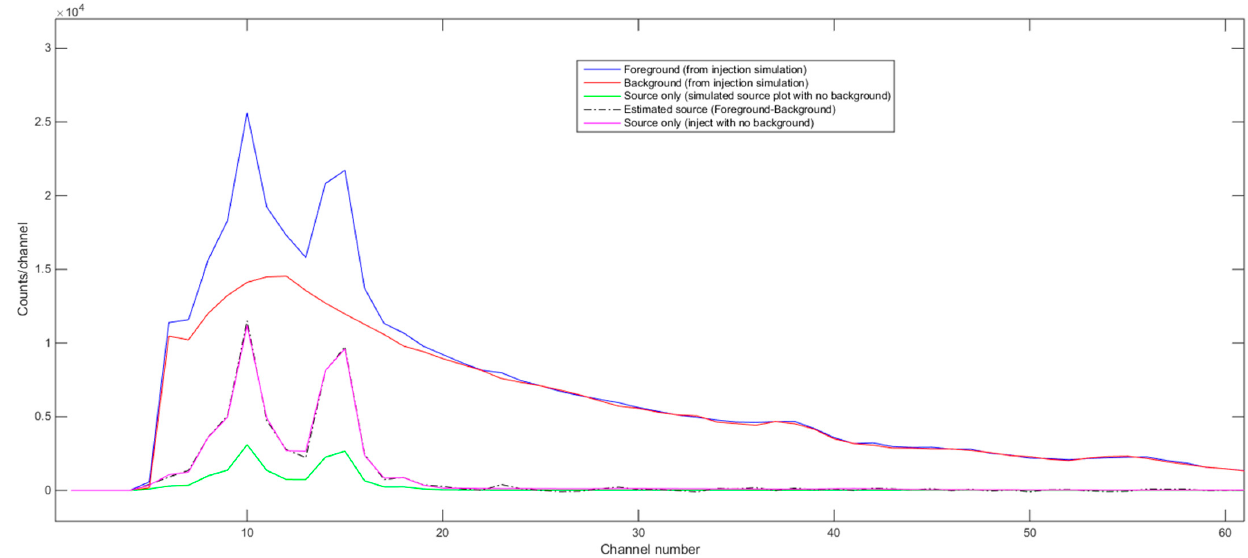
Figure 2. Estimated source spectra (foreground ‐ background) using the inject tool of GADRAS with background, using Plot tool alone and using the Inject tool with no background and no Poisson statistics for 238 U, 10 uCi source with NaI detector @ 122 cm, H = 56 cm.